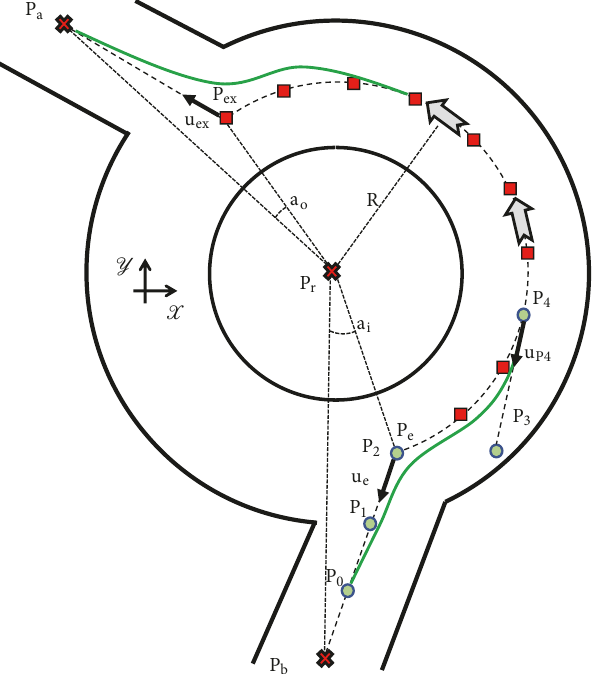
Figure 3: Trajectory planning on